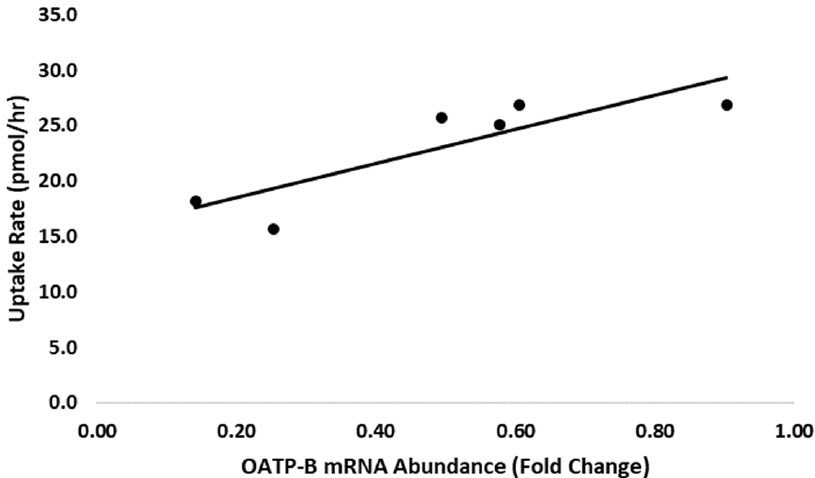
Figure 4. The expression of OATP-B in the fat was positively correlated (r = 0.86, p = 0.03) with the rate of uptake of androstenone sulfate by cultured adipocytes ( n = 6). Fat tissue samples ( n = 16) were homogenized in buffer, and the resulting supernatant was incubated with [ 3 H]-androstenone sulfate and analyzed by HPLC to quantify the pro- duction of free androstenone from androstenone sulfate in the adipose tissue. The average expression of STS was 1.13 ± 0.26, and over 4 h incubations, the average production of free androstenone from androstenone sulfate was 123.7 ± 16.4 pmol, or 30.9 ± 4.1 pmol/h. Fat androstenone concentrations ranged from 0.96 to 8.38 µ g/g with an average concentration of 3.77 ± 0.63 µ g/g, and a strong positive correlation (r = 0.76, p < 0.001) was observed between the expression of STS and the production of free androstenone from androstenone sulfate (Figure